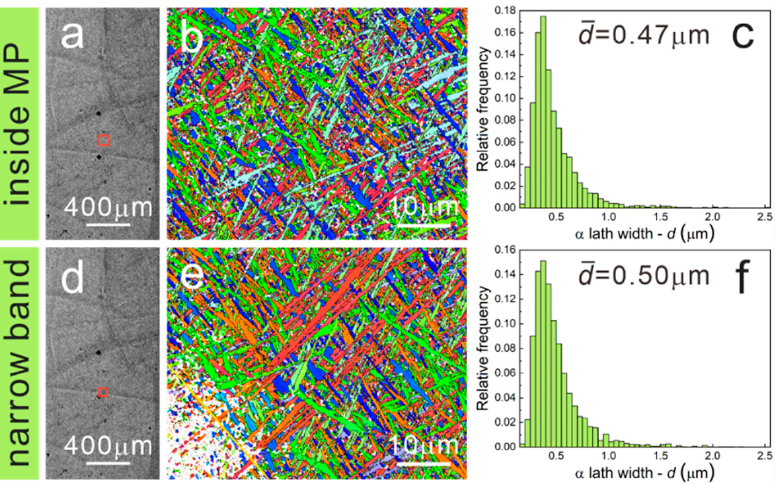
Figure 8. OM images and corresponding inverse pole figures (IPFs), α lath width distribution of the EPT8 sample: ( a – c ) narrow band, ( d – f ) inside the MP. (The black diamonds are the marking indentations of wide bands, and the red square is the EBSD scanning region.)